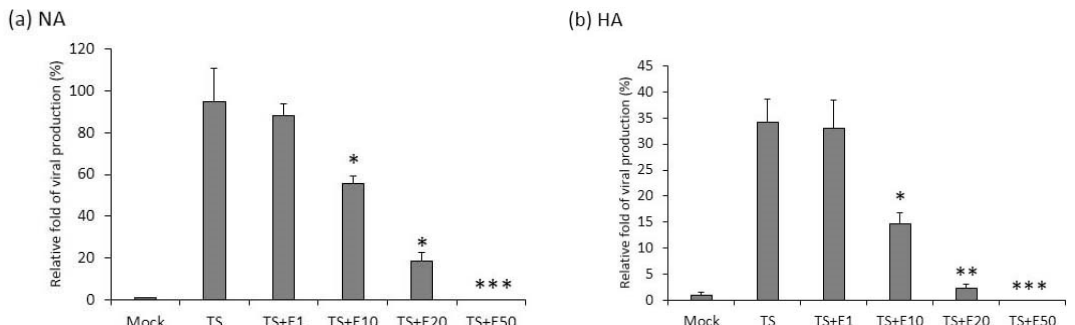
Figure 4. Virus production is inhibited by emodin treatment. EBV virions released in the culture media of NA ( a ) and HA ( b ) cells treated with TPA + SB (TS) or TS plus emodin (TS + E1, TS + E10, TS + E20, TS + E50) were collected, treated with DNase I to remove free DNA present in the media. Viral genome was purified by proteinase K digestion and subjected to qPCR analysis of EBV DNA polymerase gene fragment (BALF5). Untreated cells served as spontaneous lytic replication control (Mock). Data are means ± SD of two independent experiments. (* p < 0.05, ** p < 0.01, *** p < 0.001 compared to the TS group).